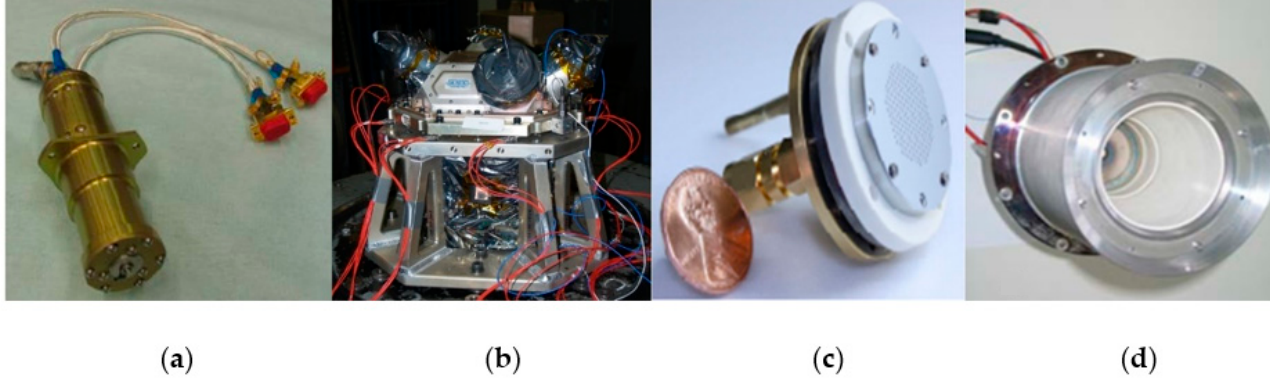
Figure 2. ( a ) Cold gas thruster, ( b ) colloid thruster, ( c ) radio frequency ion thruster and ( d ) cusped field thruster. Table 1. Four candidate thruster types and their technology readiness levels given by LISA. Thruster